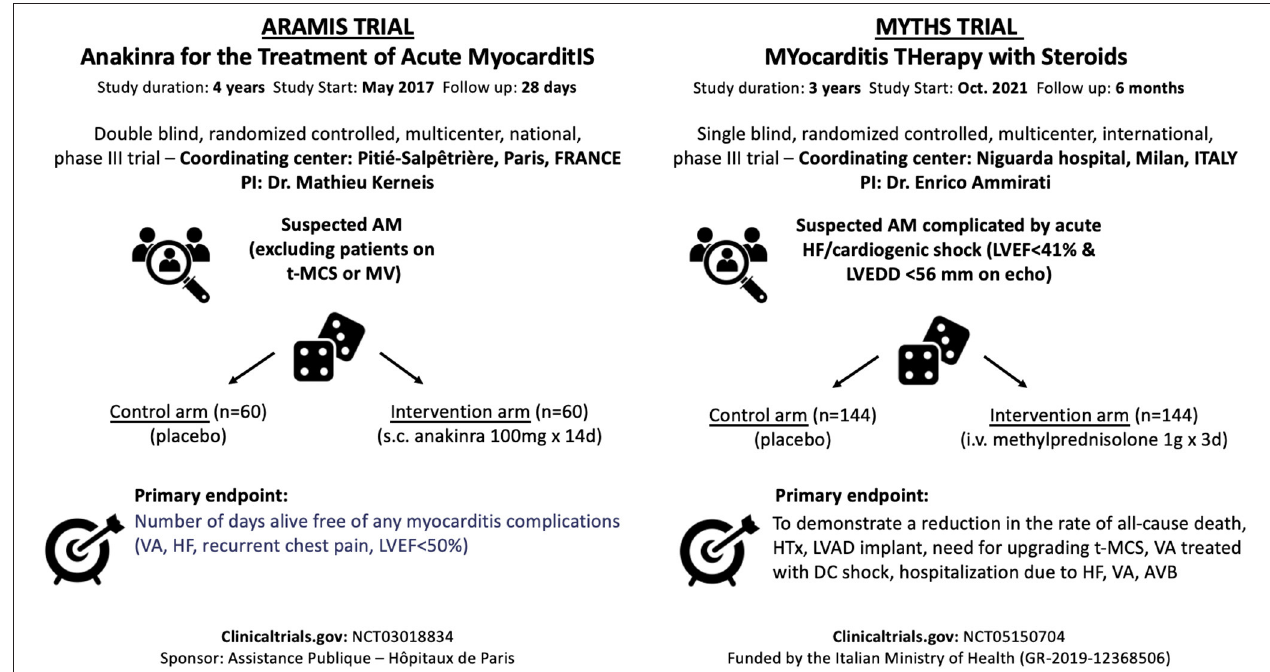
FIGURE 2 | Ongoing trials in the setting of acute myocarditis evaluating the use of immunosuppressive drugs. PI, principal investigator; AM, acute myocarditis; HF, heart failure; LVEF, left ventricular ejection fraction; LVEDD, left ventricular end-diastolic diameter; iv, intravenous; d, days; HTx, heart transplant; LVAD, left ventricular assist device; t-MCS, temporary-mechanical circulatory support; VA, ventricular arrhythmias; AVB, atrioventricular block; MV, mechanical ventilation; sc,